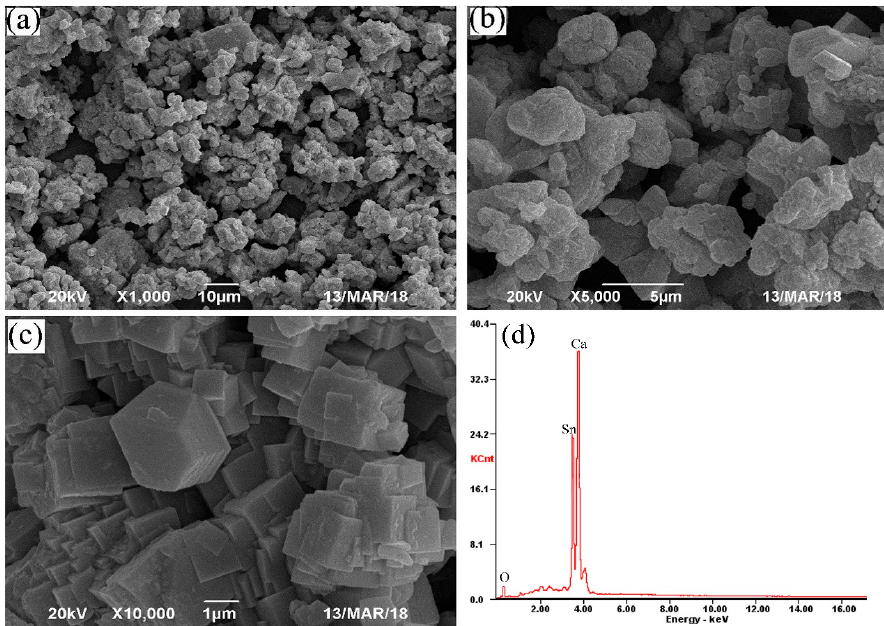
Figure 10. SEM–EDS results of the calcium stannate obtained: ( a ) 1000 times magnification; ( b ) 5000 times magnification; ( c ) 10,000 times magnification; ( d ) EDS spectrum.